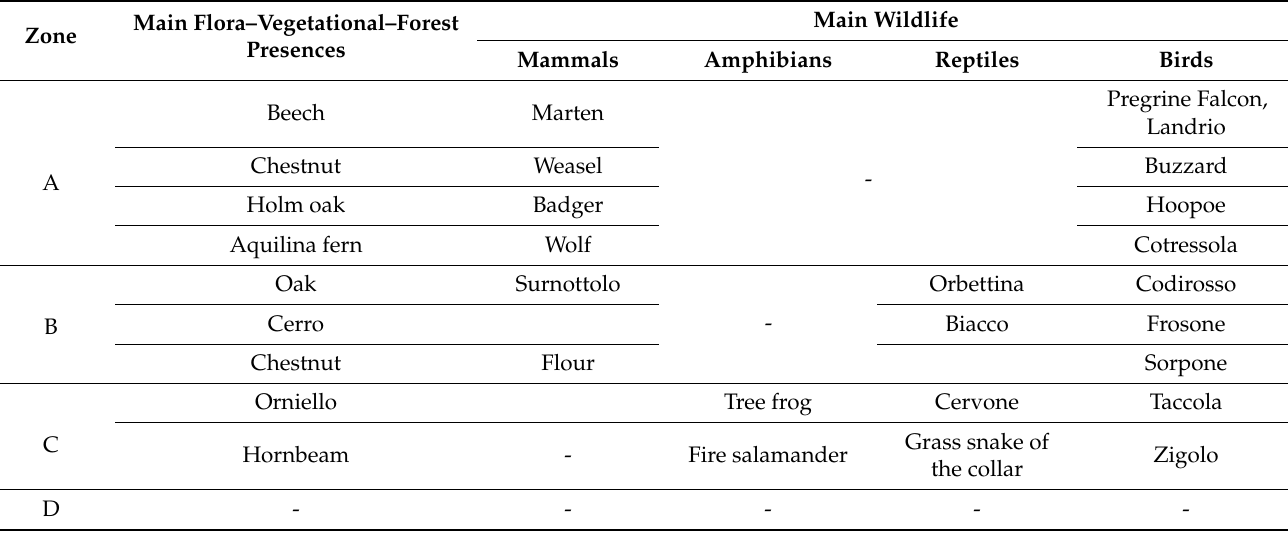
Table 2. Flora and wildlife present in the park area.